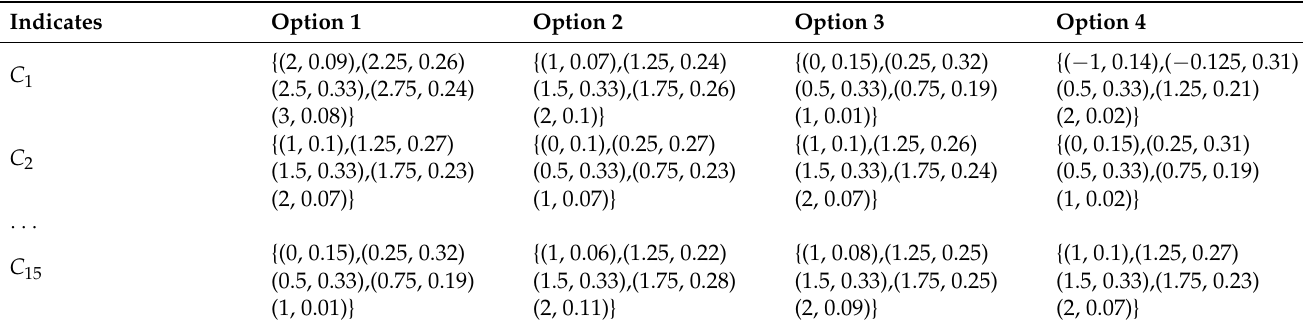
Table 4. The combined assessment information of CO 2 storage site selection.